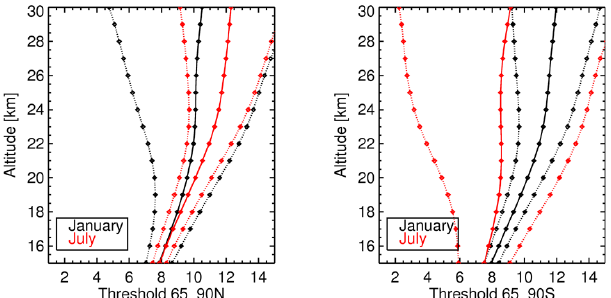
Fig. 3. Variation of Arctic and Antarctic index and σ CI profiles in January and July. Solid lines represent the calculated index profile and the dotted lines represent the range in σ CI . The large variation in σ CI reflects the impact of the change in stratospheric temperatures throughout the poles for both